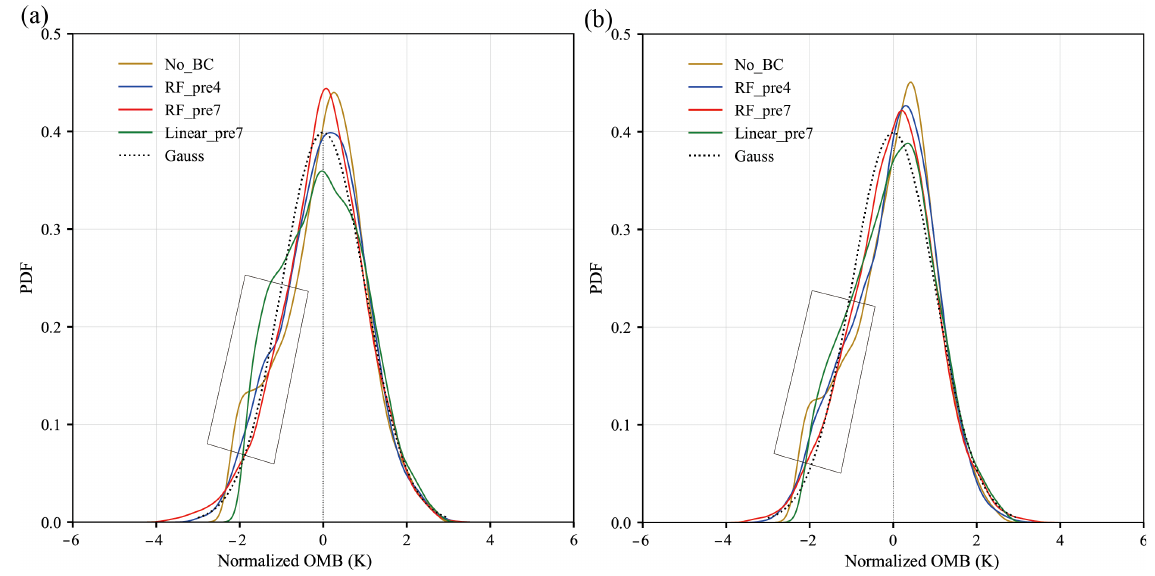
Figure 8. Probability density function (PDF) of normalized OMB departures before BC (orange curves) and after BC from the experiments of RF_pre4 (blue curves), RF_pre7 (red curves), and Linear_pre7 (green curves), respectively, versus the Gaussian distribution (black dotted curves) for AGRI ( a ) channel 9 and ( b ) channel 10.